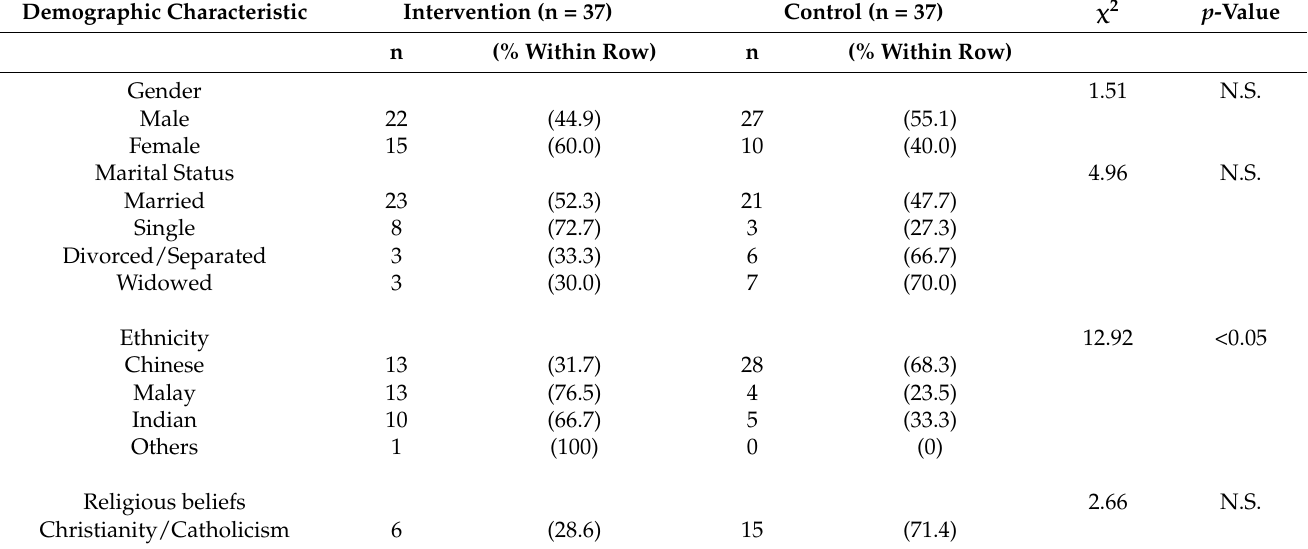
Table 1. Demographic characteristics and baseline outcomes of participants by